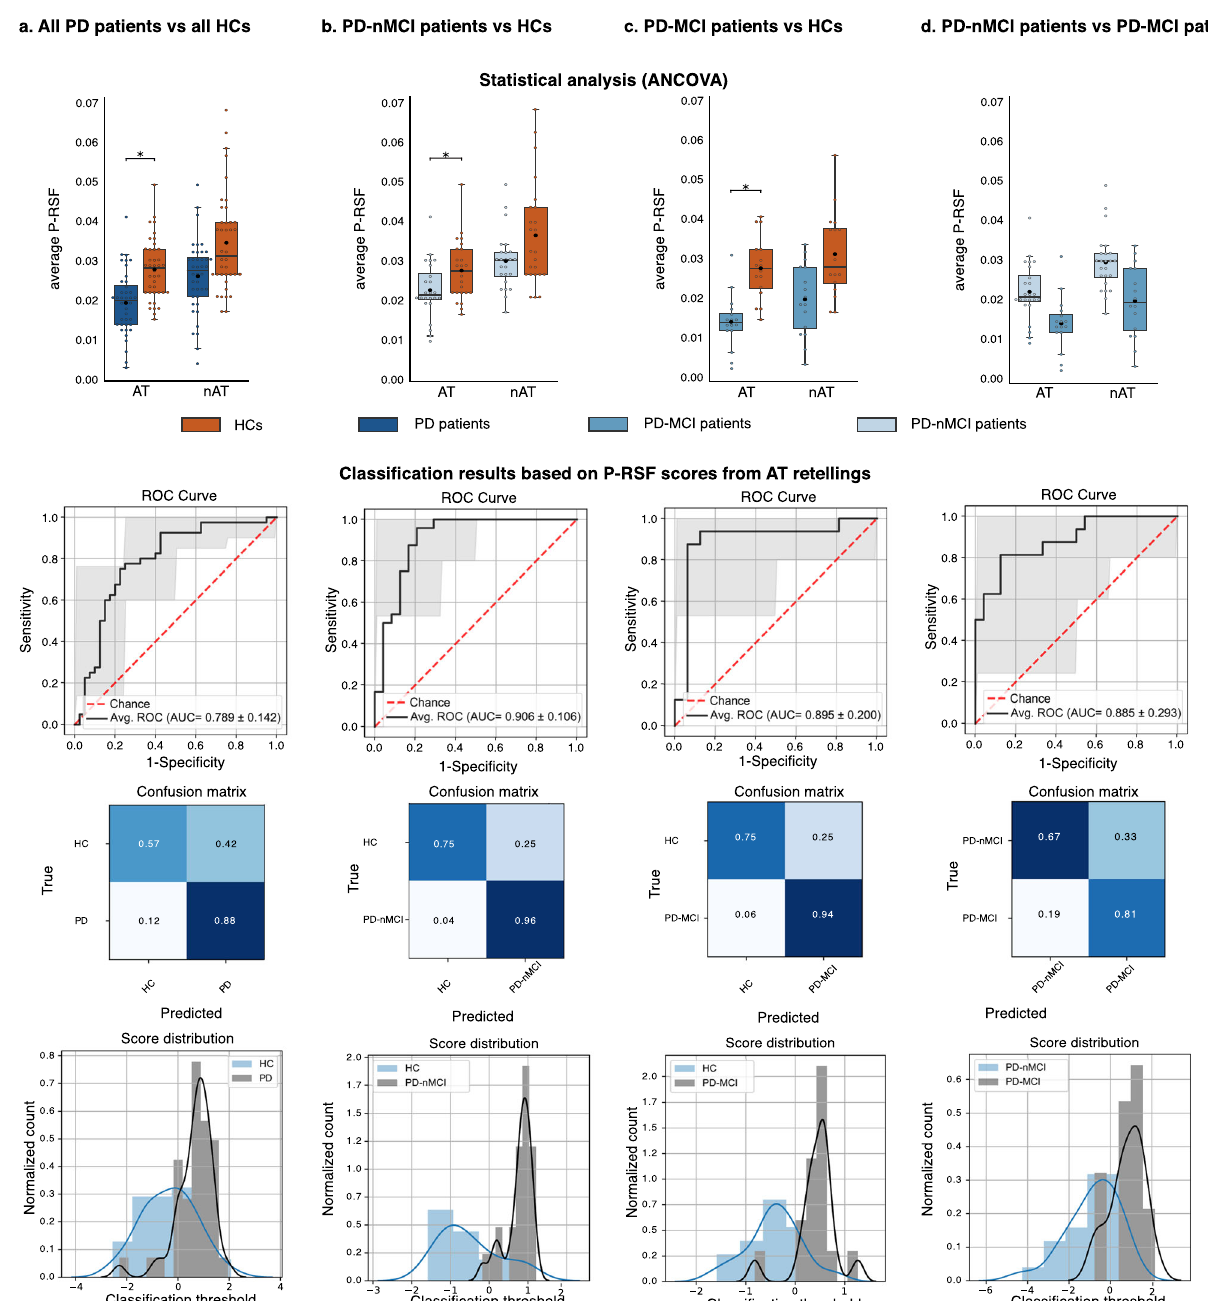
Fig. 2 Statistical comparison between groups in each tandem (top insets) and classi fi cation results using action texts (lower insets). a All PD patients vis-à-vis all HCs. b PD-nMCI patients vis-à-vis HCs. c PD-MCI patients vis-à-vis HCs. d PD-nMCI vis-à-vis PD-MCI patients. AT action text, nAT non-action text, P-RSF Proximity-to-Reference-Semantic-Field, PD Parkinson ’ s disease, PD-MCI Parkinson ’ s disease with mild cognitive impairment, PD-nMCI Parkinson ’ s disease without mild cognitive